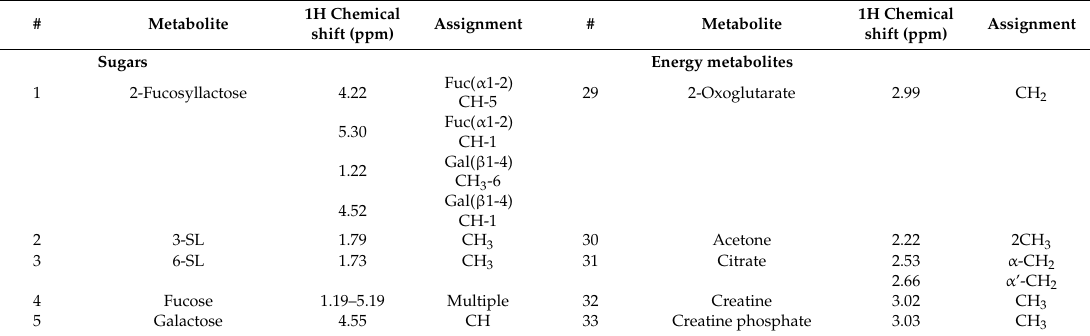
Table 1. List of identified metabolites with chemical shifts in ppm from internal sodium salt (TSP) standard and assignment